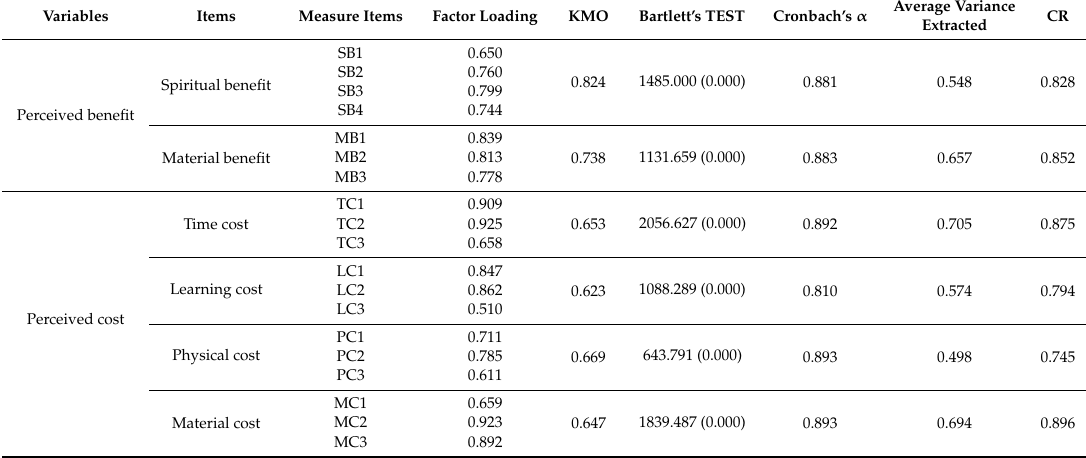
Table A2. Results of factor analysis.